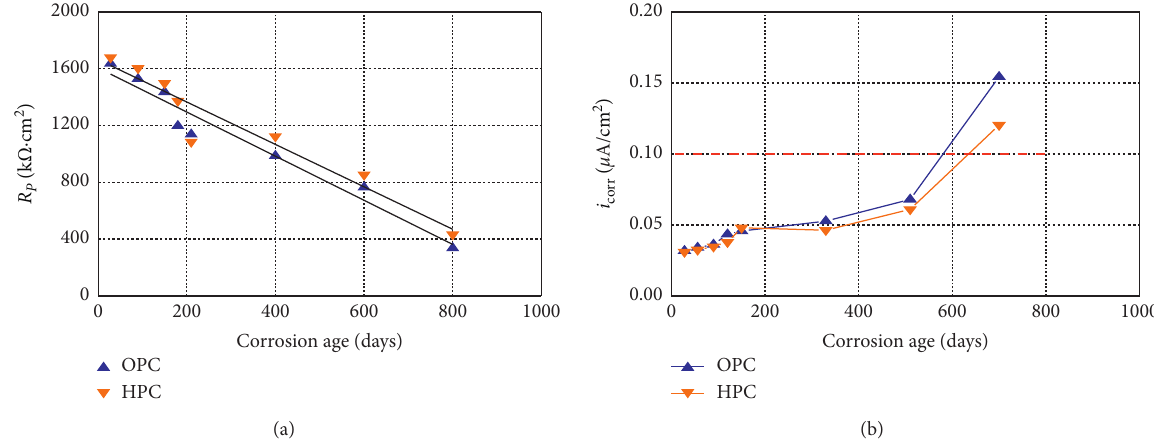
Figure 15: RP and i corr of reinforced concrete exposed to submerged zone. (a) RP. (b) i corr